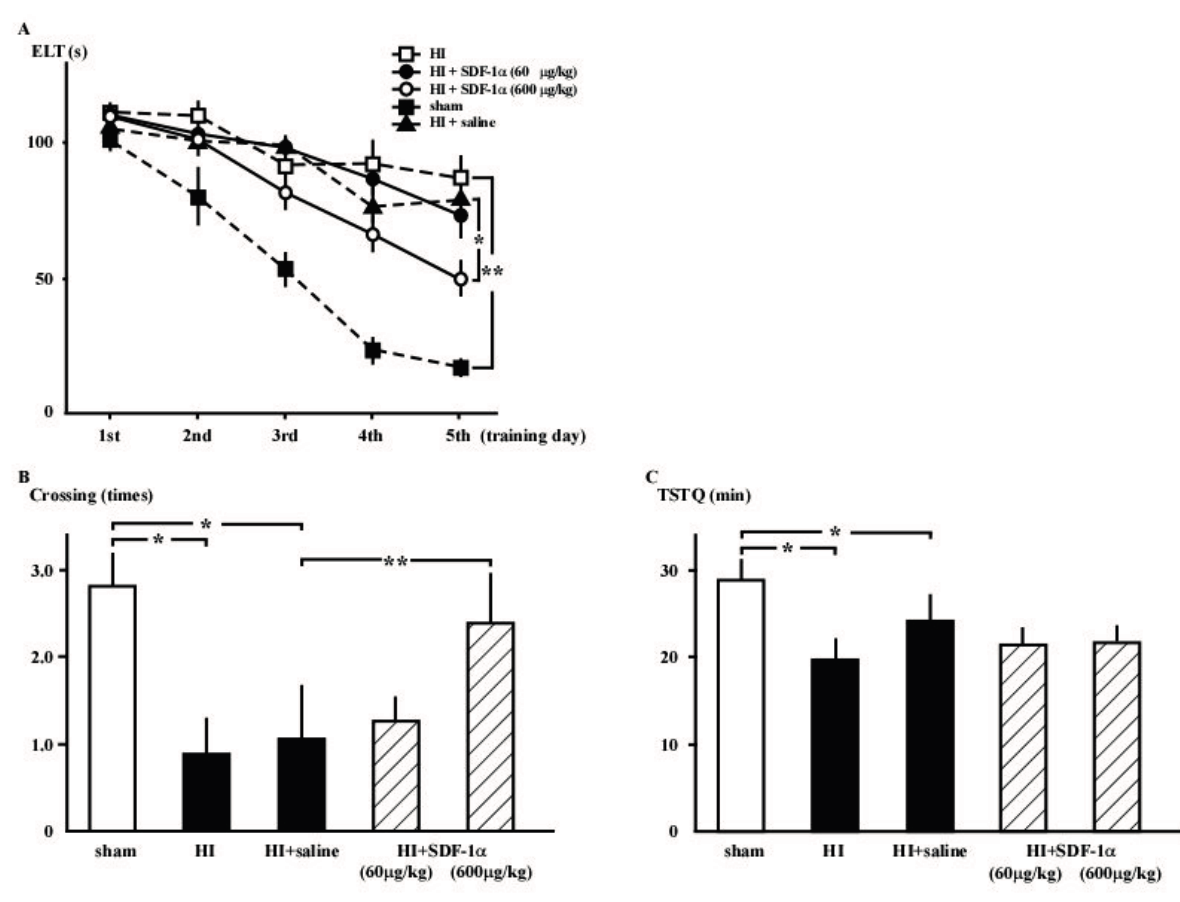
Figure 2. MWM test results, demonstrating that surgery disturbs spatial learning and memory in neonatal rats. ( A ) Sham group: filled squares with a dotted line. HI group: open squares with a dotted line. HI + SDF-1 α (60) group: Solid circles with a solid line. HI + SDF-1 α (600) group: open circles with a solid line. The ELT was significantly decreased by training and inhibited in the HI group compared to the sham group ( ** p < 0.01). ELT was restored by intracranial injection of 600 μ g/kg SDF-1 α ( * p < 0.05); ( B ) Number of crossings was significantly decreased in the HI group ( n = 14; * p <